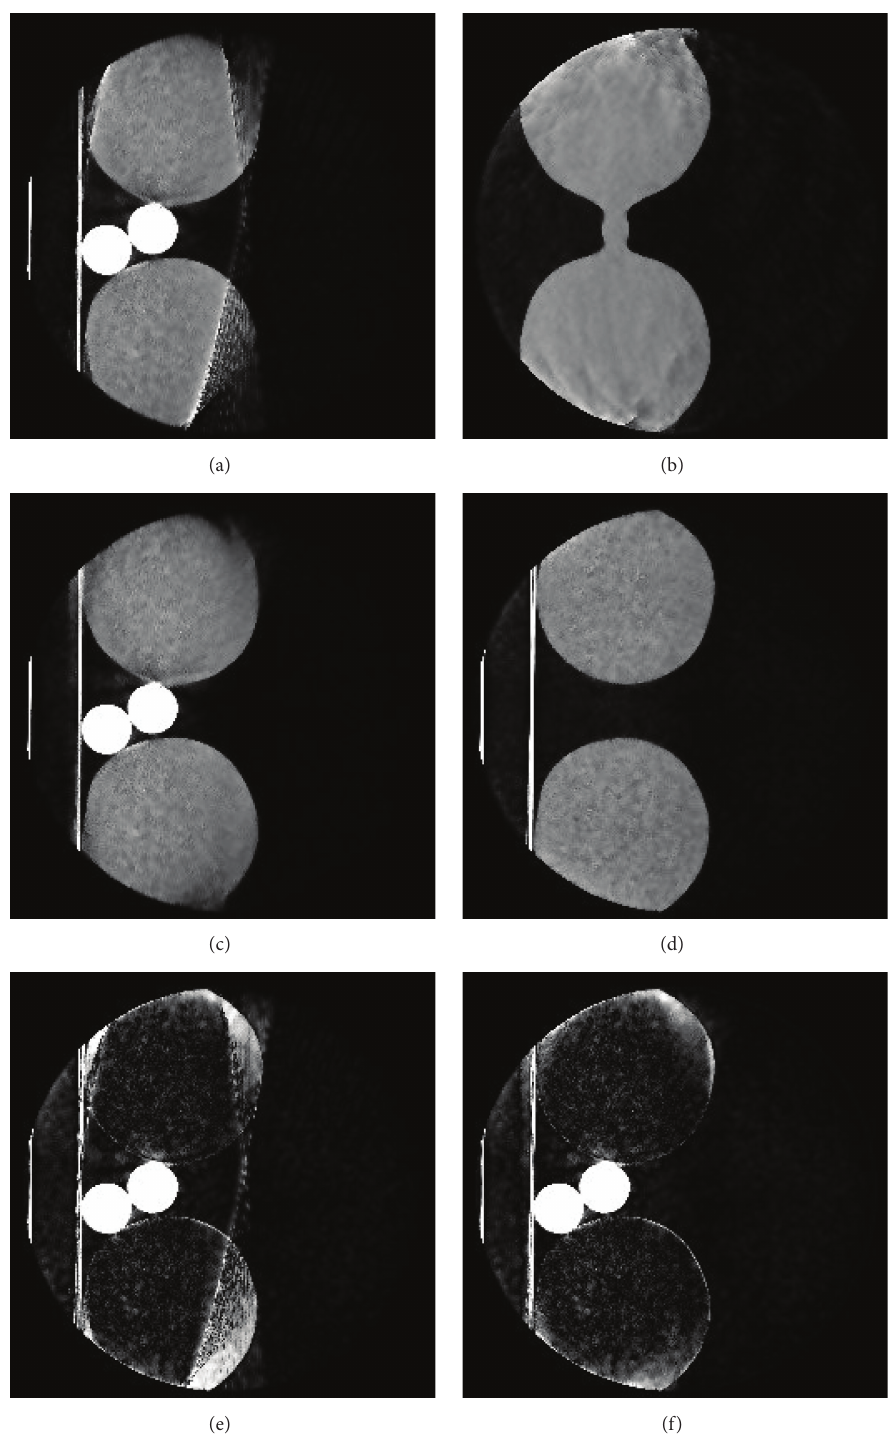
Figure 11: (a) shows a slice of the uncorrected volume. Severe artifacts deriving from saturation are visible on the right exterior regions of both bottles. (b) shows the corresponding slice to (a) which has been reconstructed by solely using the intersection lengths obtained from the depth data. These values are used for the correction of the saturation artifacts. A slice of the resulting corrected volume can be seen in (c). (d) shows the reconstruction of the nonoverexposed knee phantoms. The bone phantoms have been removed to acquire this ground truth reference. For further demonstration of the results, the absolute difference between the ground truth and the uncorrected data (e) and the corrected data (f) is visualized. The two dense rods between the two water cylinders have a density of 1000g/cm 2 , simulating the femurs in the legs. Window level (a)–(d): [ − 1000, 1000]. Window level (e) and (f): [0,